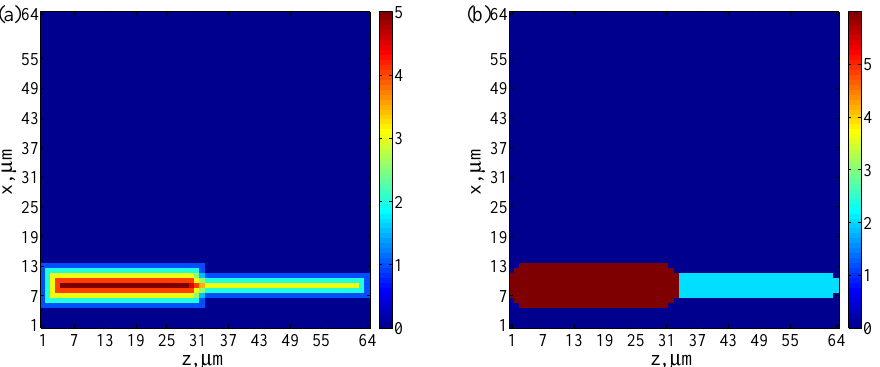
Figure 14. ( a ) Distribution of d for a one-cell-thick layer of model two. ( b ) Distribution of w for a one-cell-thick layer of model two.